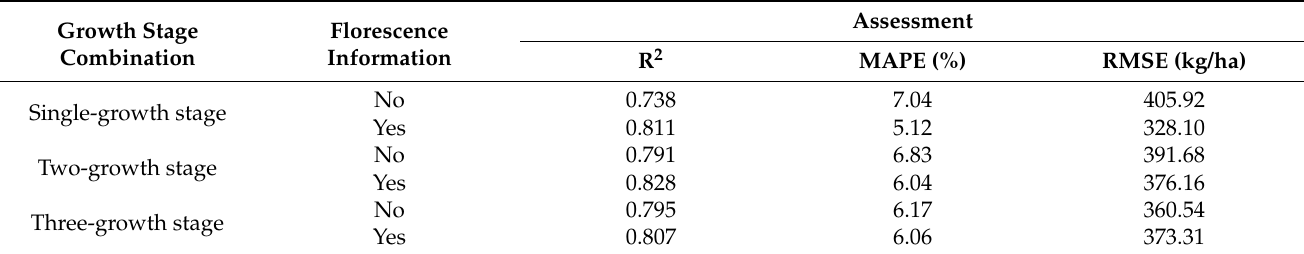
Table 7. Comparisons of the yield estimation models with and without considering florescence spectral information for the validation